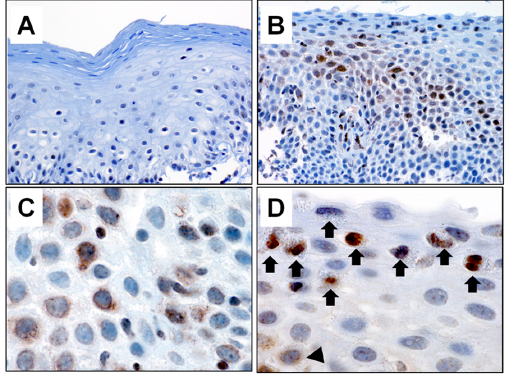
Figure 3. Eotaxin-3 immunostaining of esophageal biopsy specimens. (A) Normal squamous epithelium shows no eotaxin-3 immunostaining. (B) Eotaxin-3 labels epithelial cells with variable intensity in biopsies with esophageal eosinophilia. (C) High power magnification (1000x) identifies a granular cytoplasmic staining that is perinuclear. (D) Eosinophils also showed eotaxin-3 immunostaining, but were readily identified by their morphological features and excluded from quantification. Arrows indicate eosinophils with eotaxin-3 labeling. The isolated arrowhead in the bottom left indicates a squamous epithelial cell with weak perinuclear